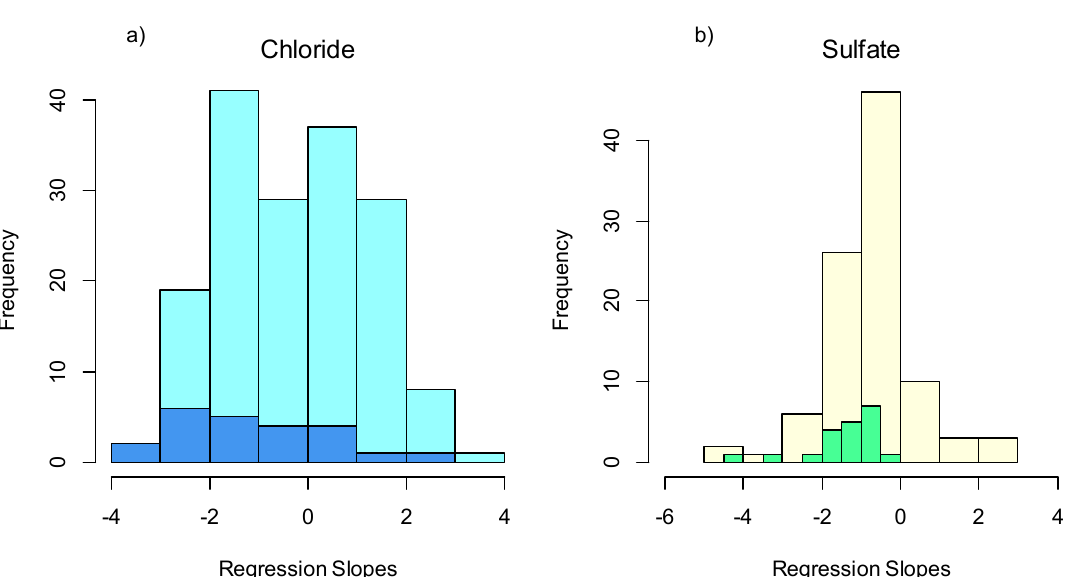
Figure 8. Histograms of slopes (x-axis) for individual taxa reported from logistic regression for ( a ) chloride and ( b ) sulfate. The subset of slopes for mayfly taxa are shown as inset overlaying histograms.